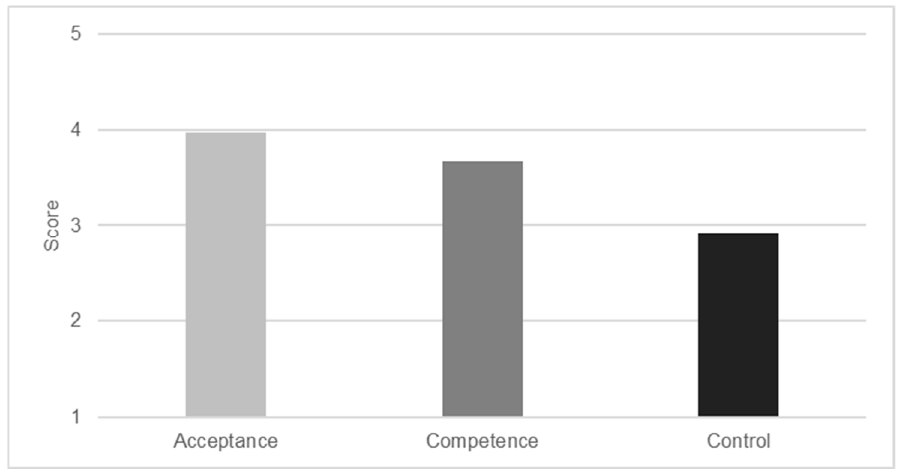
Figure 7. Average score of the clusters Acceptance , Competence and Control over all companies.